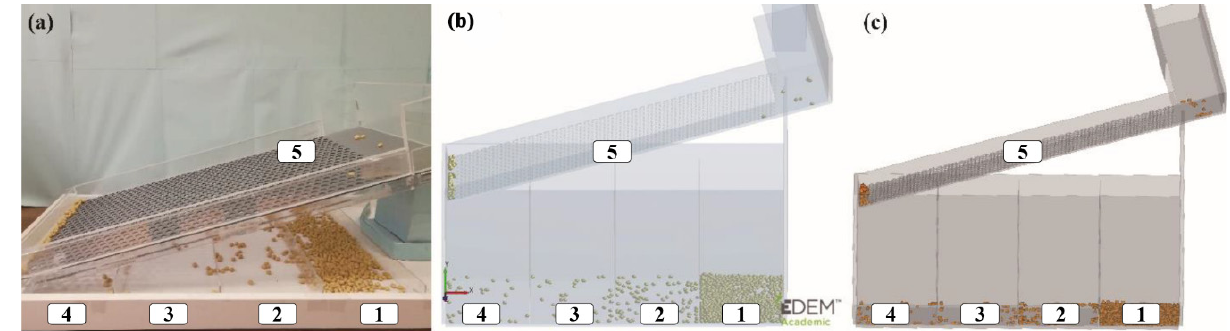
Figure 14. ( a ) Test photo, ( b ) EDEM software simulation snapshot, and ( c ) DEMSLab software simulation snapshot of the “self-flow screening”.